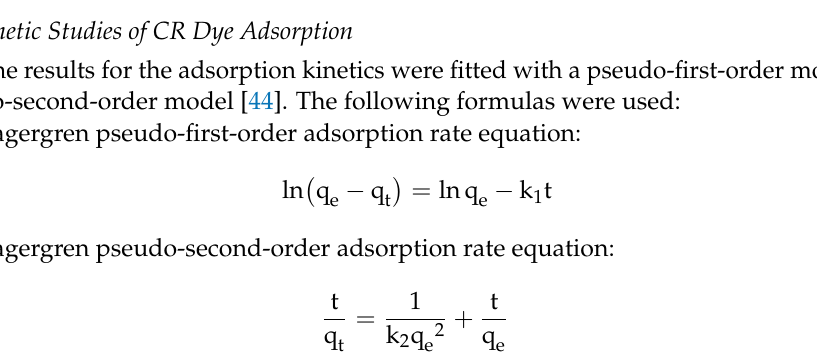
Figure 3. The CR removal rates for ( a ) raw coal and ( b ) SC with different adsorbent dosages.